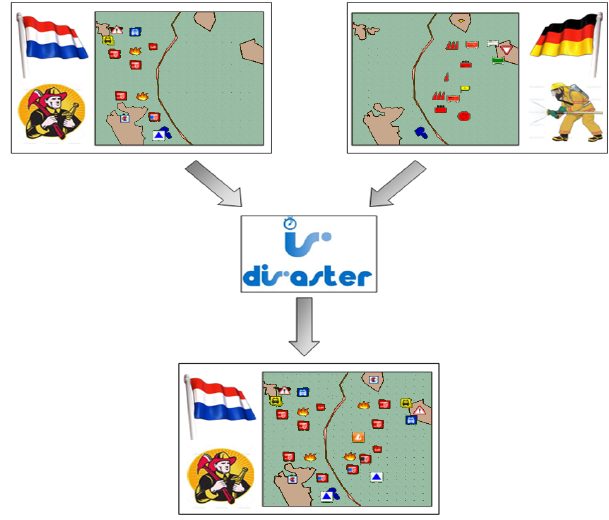
Figure 6. Combining German and Dutch common operational pic- tures (cross-border